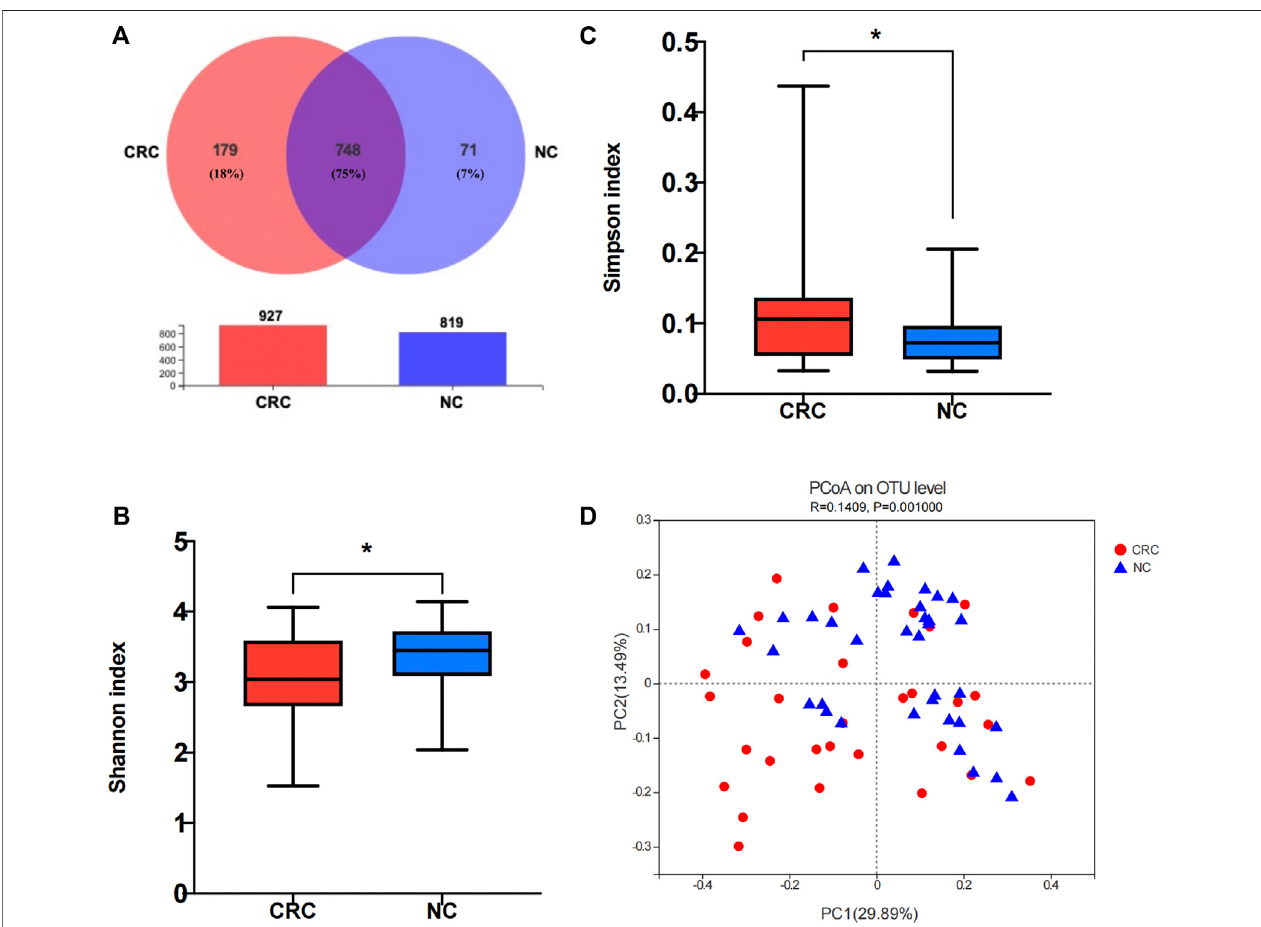
FIGURE 1 | Comparison of the fecal microbiome composition between the CRC and NC groups. (A) Venn diagram of operational taxonomic units (OTUs) in CRC patients and NC controls. (B,C) α -diversity of 16S rRNA genes in the gut microbiota of CRC patients and NC controls. (D) Principal coordinate analysis (PCoA) of a weighted UniFrac distance analysis. NC, normal colorectal mucous membrane; CRC, colorectal cancer.